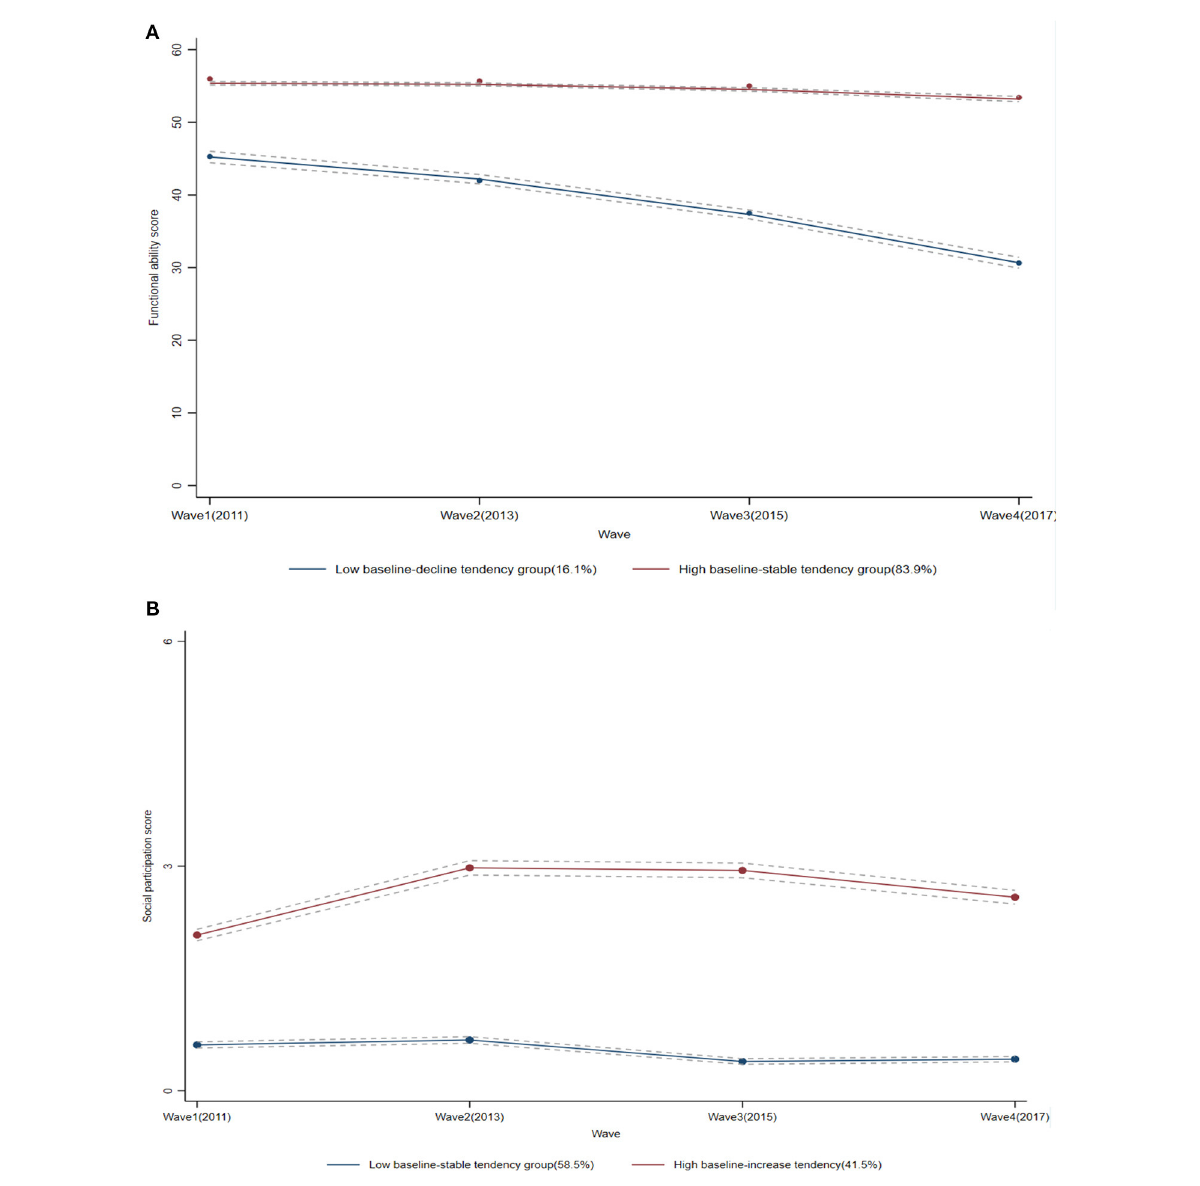
FIGURE1 Trajectories of the functional ability scores and the social participation scores. The solid lines represent estimated values, and the dotted lines show the 95% CIs. (A) The functional ability scores; (B) the social participation scores.